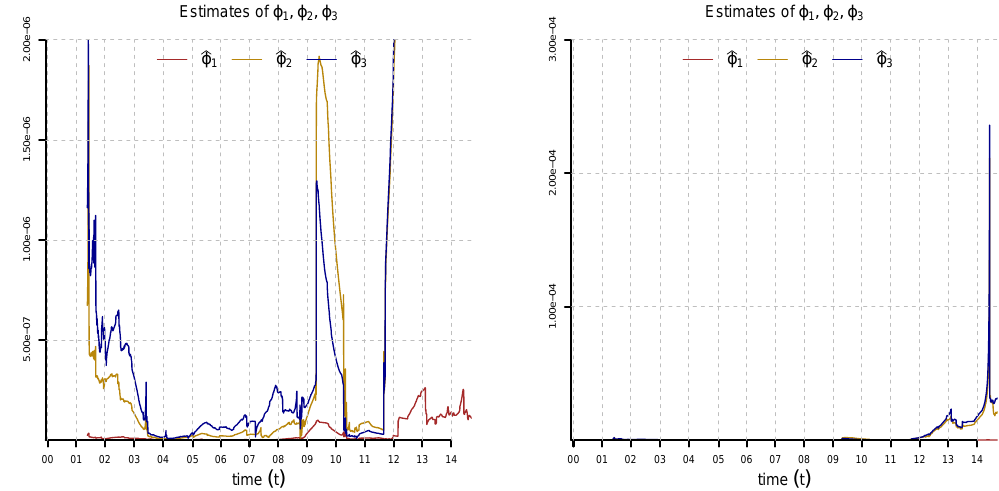
Figure 16. Estimation of ϕ 1 , ϕ 2 and ϕ 3 by least square regression (two different scales). We use a time window of 252 observations for the regression.